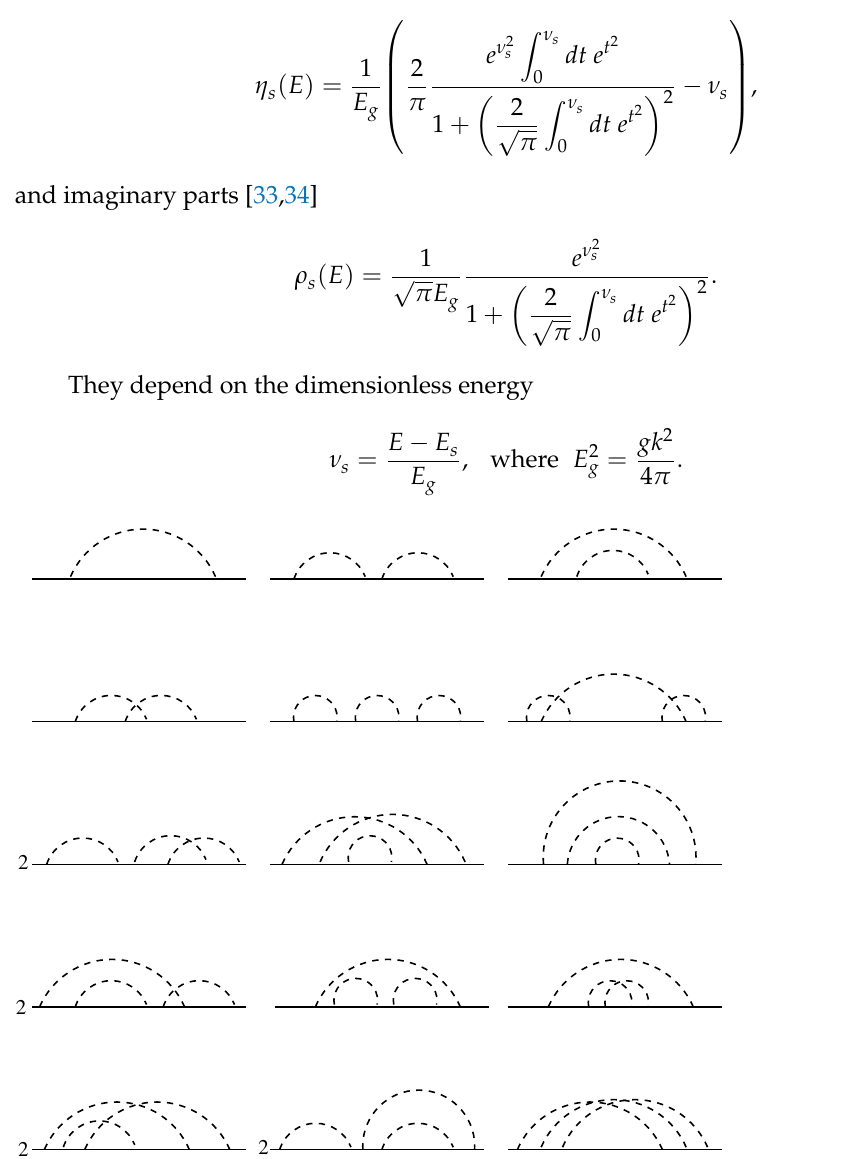
Figure 3. Perturbative processes contributing to the dressing of the single-particle propagator due to the disorder to order g 1 (one diagram), g 2 (three diagrams), and g 3 (fifteen diagrams). Some of the diagrams of order g 3 should be counted twice because of the degeneracy due to the mirror symmetry with respect to the imaginable vertical axis, which is accounted for by the factors 2 in front of